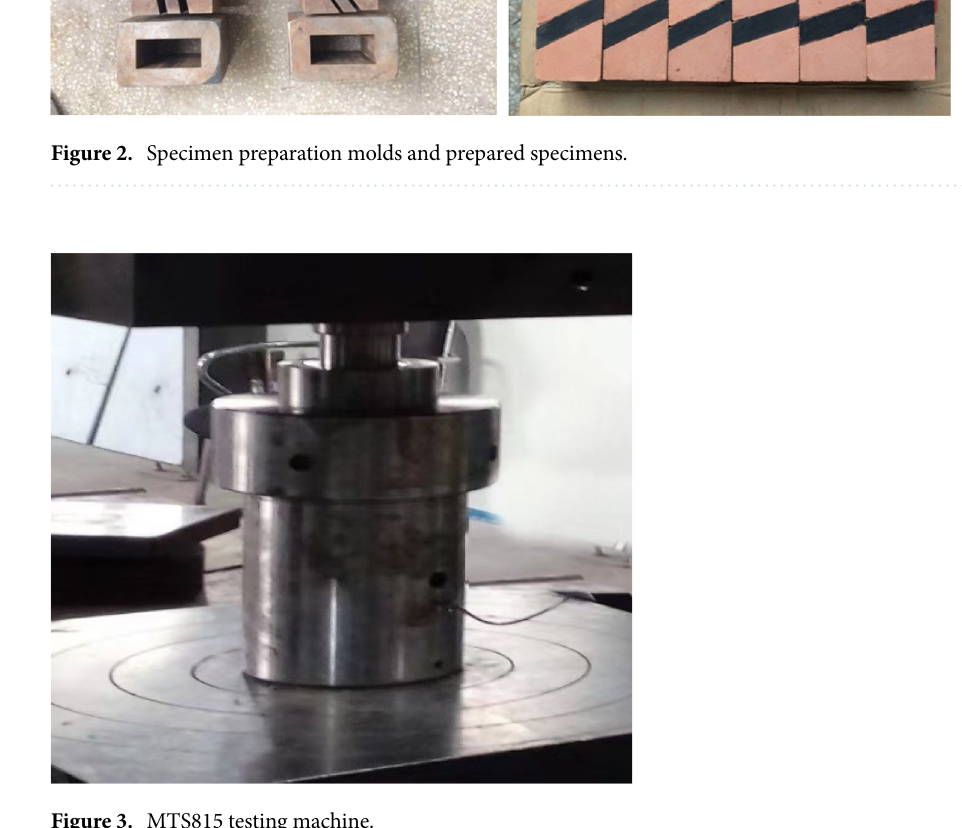
Figure 3. MTS815 testing